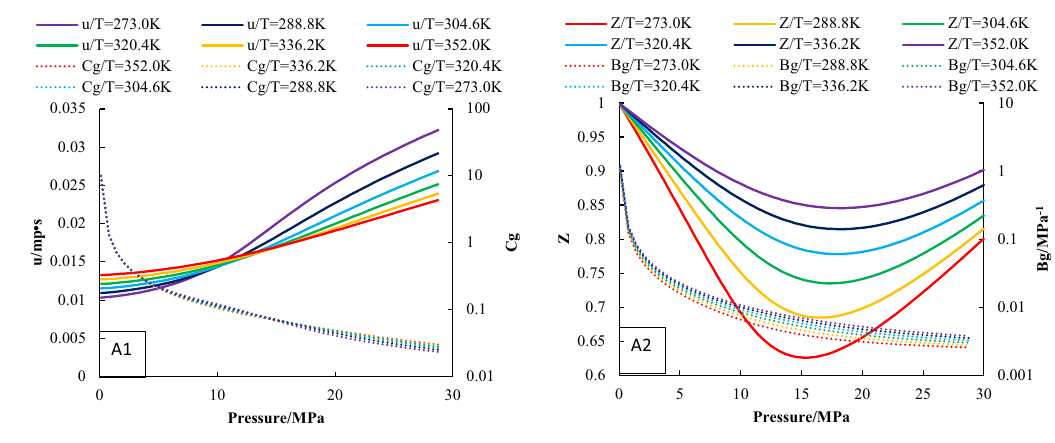
Fig. 11 Property curve of natural gas (A1: P – μ curve of natural gas and P–C of natural